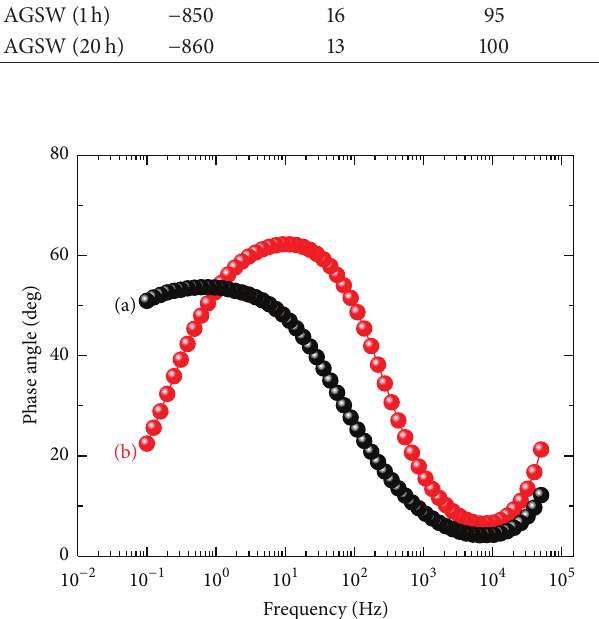
Figure 5: Bode phase angle plots obtained for the API X70 pipeline steel after its immersion for (a) 1h and (b) 20 h in Arabian Gulf seawater.